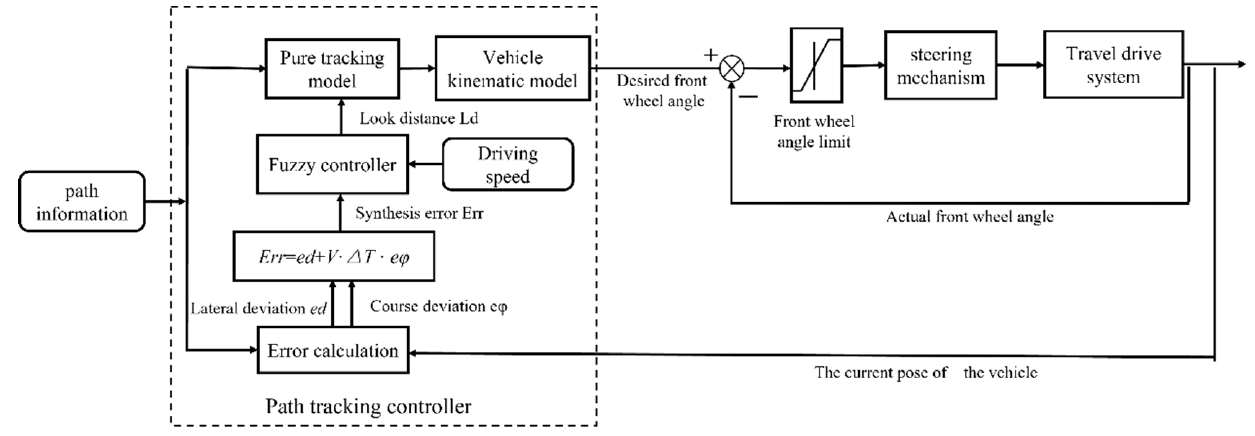
Figure 1. Schematic diagram of the path tracking system.